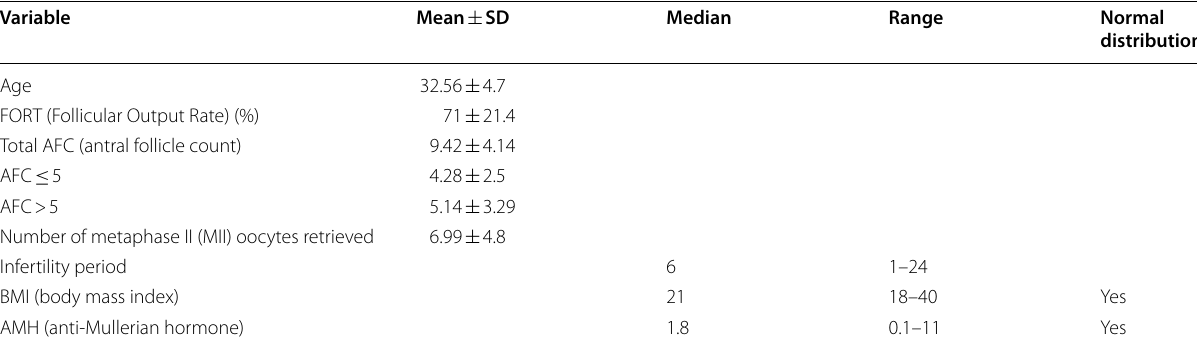
Table 1 The demographic and reproductive data